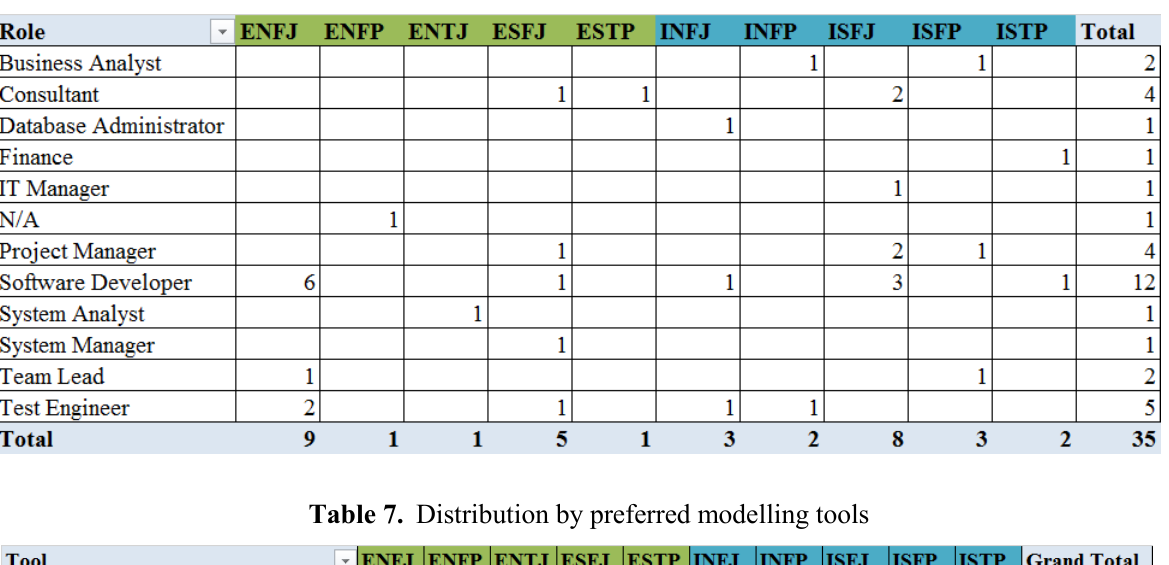
Table 6. Distribution by competence area